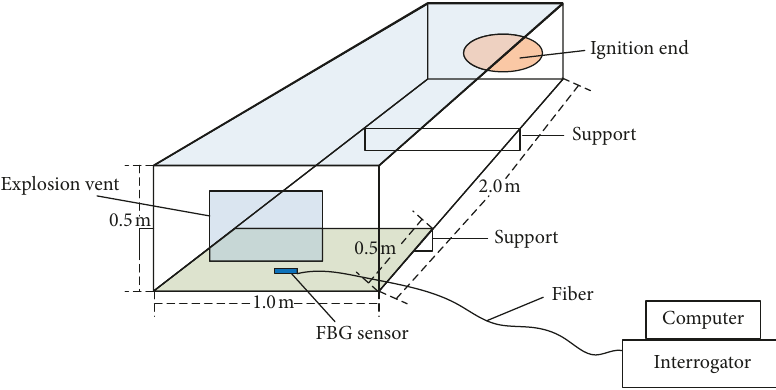
Figure 7: Test device dimensions and sensor position.